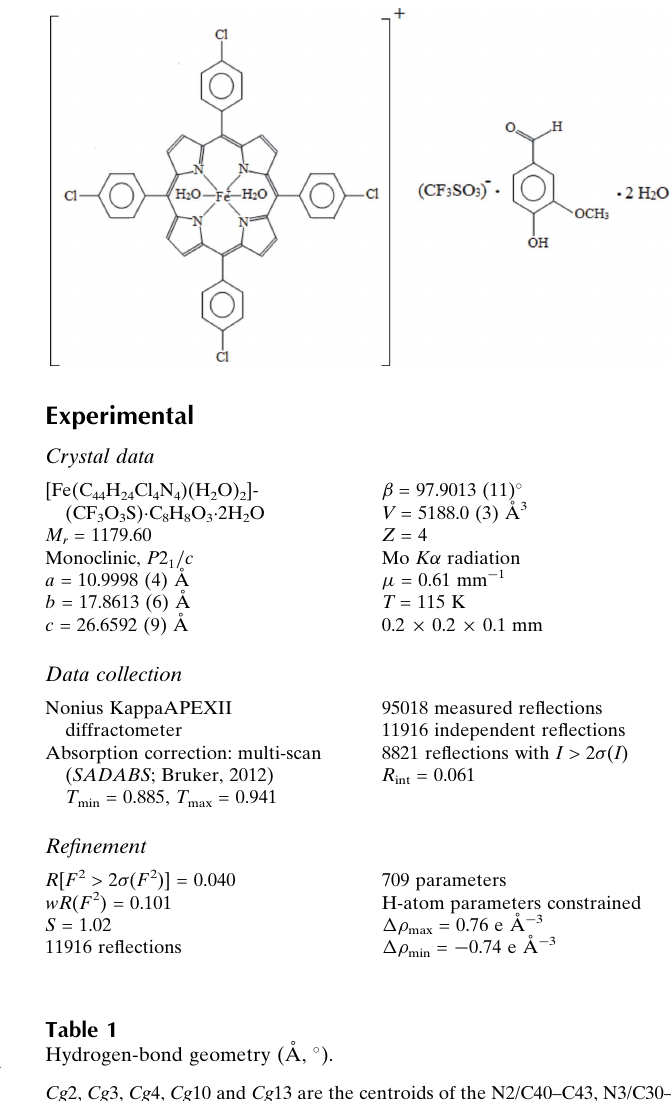
Hydrogen-bond geometry (A˚ , (cid:3)